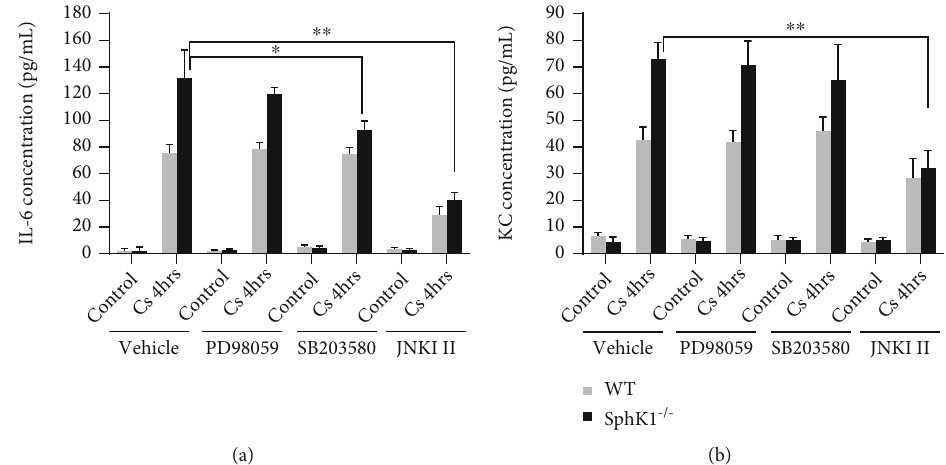
Figure 6: JNK plays a critical role in sphingosine kinase 1-mediated in fl ammatory response to cyclic stretch. The isolated ECs were seeded on Flexcell plates overnight in the presence of the indicated inhibitors. After cyclic stretching (CS) (18% elongation, 0.5Hz, 4 hours) as described in Figure 4, the medium was harvested for ELISA. (a) IL6 and KC assay showed that SphK1 knockout signi fi cantly enhanced CS-mediated IL6 and KC generation. The SphK1 knockout-mediated IL6 generation enhancement was not signi fi cantly abolished by PD98059 but partially by SB203580 and completely by JNK inhibitor II. (b) The SphK1 knockout-mediated KC generation enhancement was not signi fi cantly abolished by PD98059 and SB203580, but completely by JNK inhibitor II ( ∗ P < 0 : 05 , ∗∗ P < 0 : 01